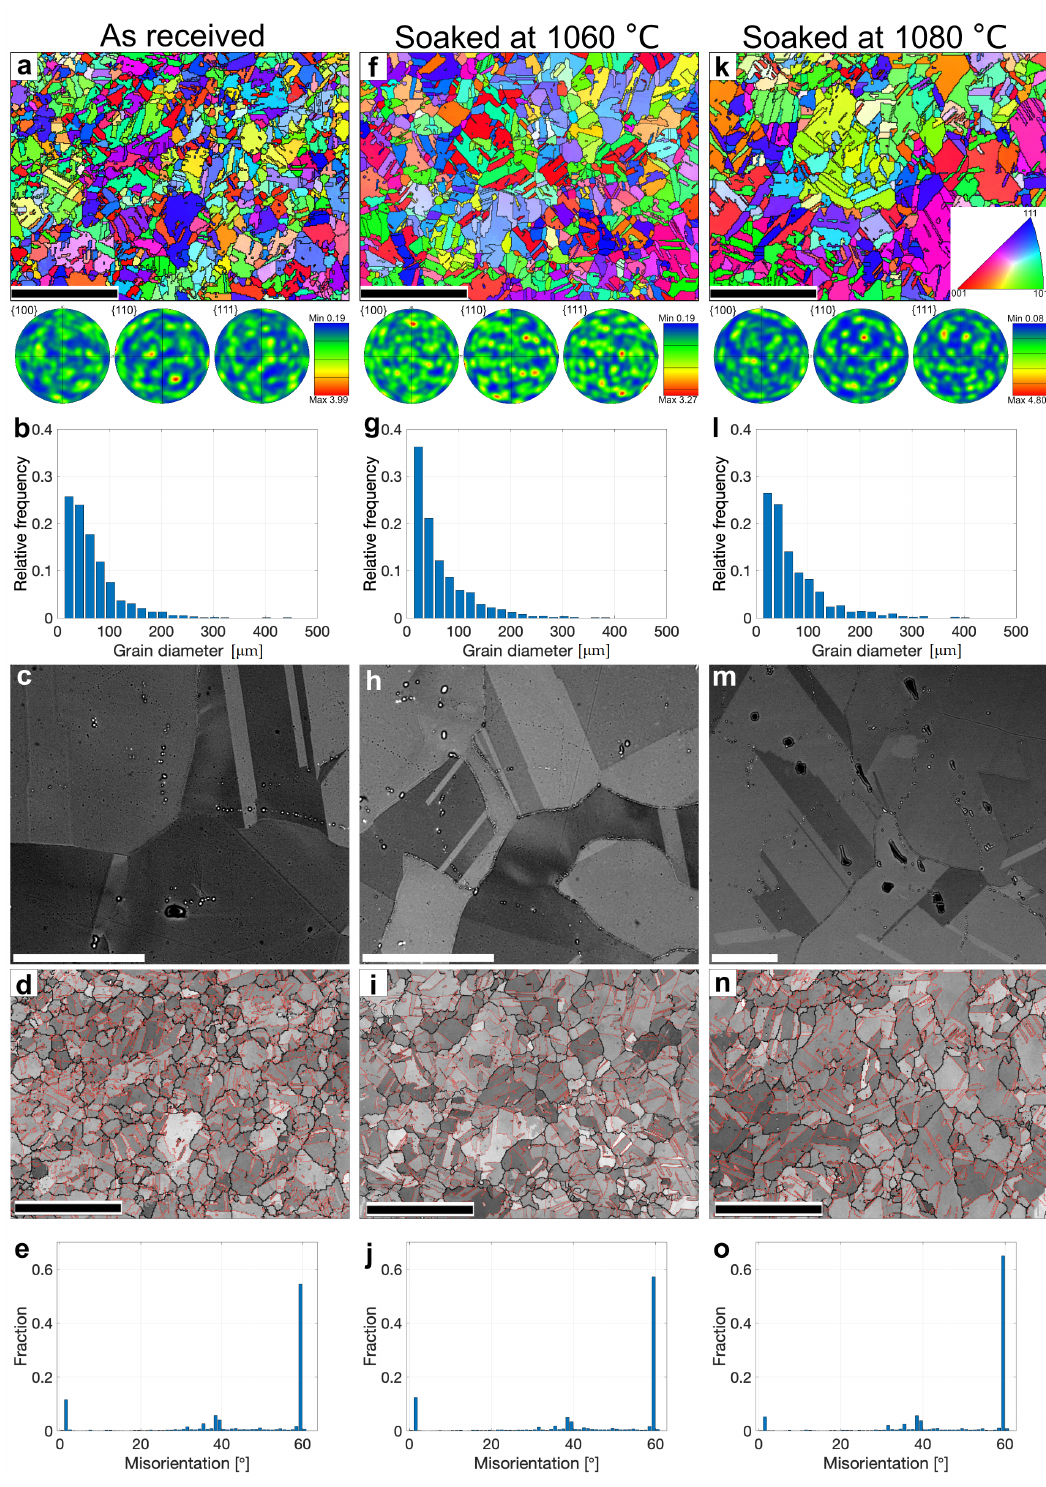
Figure 2. Initial microstructures for the billet in as-received condition ( a – e ), soaked at 1060 ◦ C ( f – j ) and at 1080 ◦ C ( k – o ). ( a , f , k ) show IPF maps (black lines are HAGB > 10 ◦ ), with corresponding {100}, {110} and {111} pole figures (orientation with respect to the compression direction during subsequent deformation, horizontal in the images). ( b , g , l ) shows the grain size distributions from the EBSD measurements. ( c , h , m ) shows backscattered electron images of grain boundaries, revealing the absence of grain boundary carbides in ( c ) and their presence in ( h , m ). ( d , i , n ) shows twin boundaries (red lines) superposed on band contrast maps. ( e , j , o ) show grain boundary misorientation distributions. Black scale bars are 1 mm and white are 50 µ